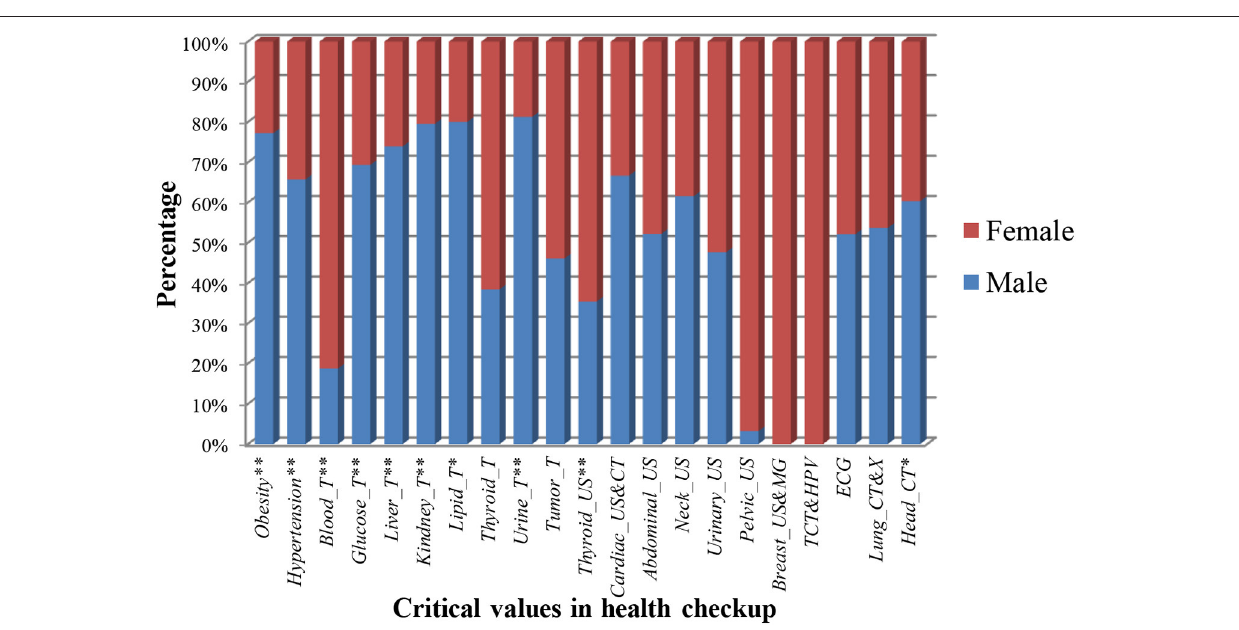
FIGURE 2 | The prevalence of critical values in health checkup for different genders. * and ** denote the statistically significant difference in the 0.05 and 0.01 tested levels.